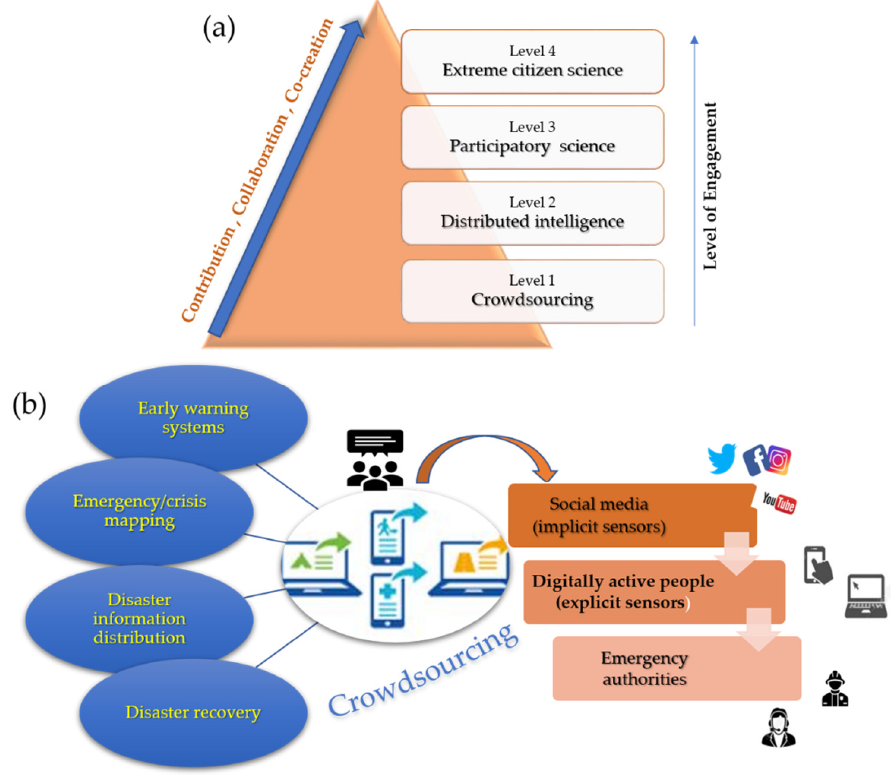
Figure 10. Classification of citizen science by increasing levels of engagement, according to Haklay, 2013 ( a ) and role of crowdsourcing ( b ).